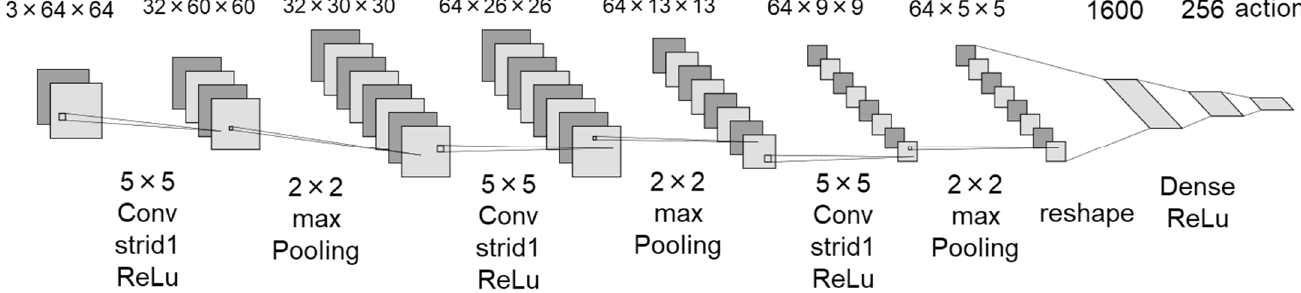
Figure 6. The architecture of the Q-Network.